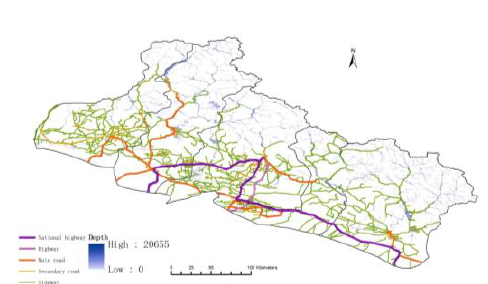
Figure 9. The road affected by the flood at a given